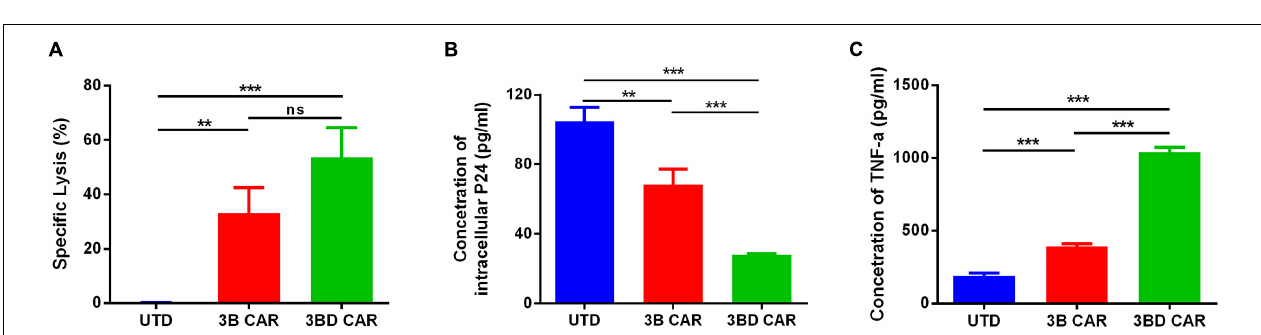
FIGURE 4 | Suppression of spreading HIV-1 infection in CD4 + by 3B and 3BD CAR-T cells. (A) Primary CD4 + T cells were infected with HIV-1 NL4 − 3 and mixed with anti-HIV CAR-T cells at different ratios (0.5:1; 1:1; and 2:1). 24 h after co-culture, specific cytotoxicity was measured by LDH assay. (B) 48 h after co-culture, the p24 concentration in supernatant was tested. (C) To evaluate long-term suppression effects, wild type virus challenge of CAR T cells during a 6-day co-culture with HIV-infected allogenic CD4 + T cells at a 2:1 ratio. (D) Every two days the cultures were tested for the presence of p24 in the supernatant by ELISA. The significance shown is a comparison of each condition versus 3BD CAR. Statistical analyses were performed using the Tukey method for ANOVA for multiple comparisons. ns p > 0.05, * p < 0.05, ** P < 0.01, *** P < 0.001. Error bars show ± SEM.